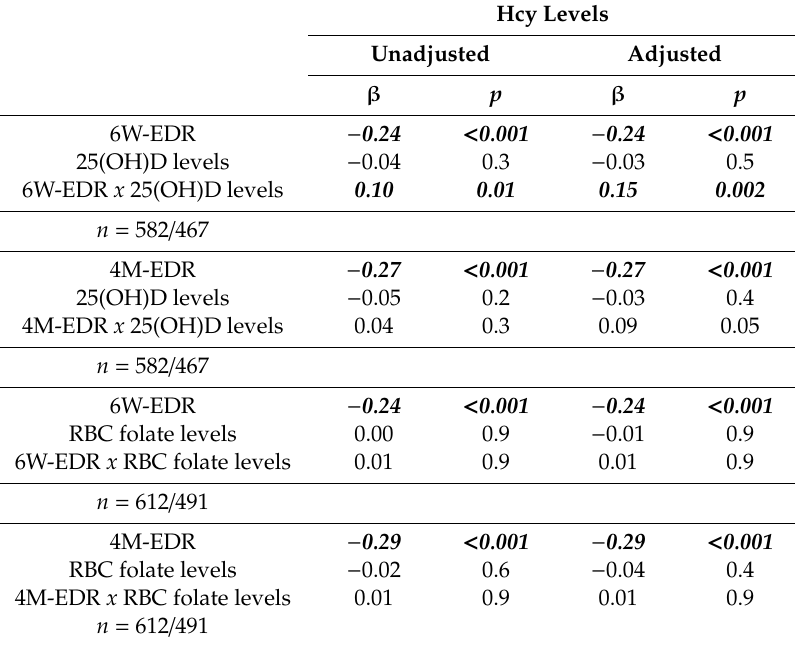
Table 3. Assessment of interactions between EDR measures (6W-EDR and 4M-EDR) and levels of 25(OH)D or RBC folate in determining Hcy levels, with and without adjustments.